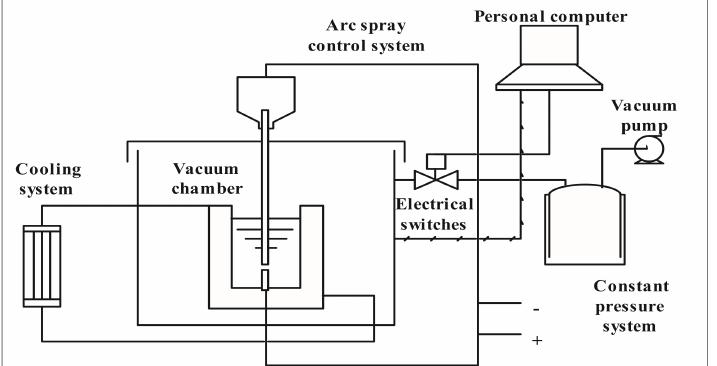
Figure 5. Schematic diagram of submerged arc method